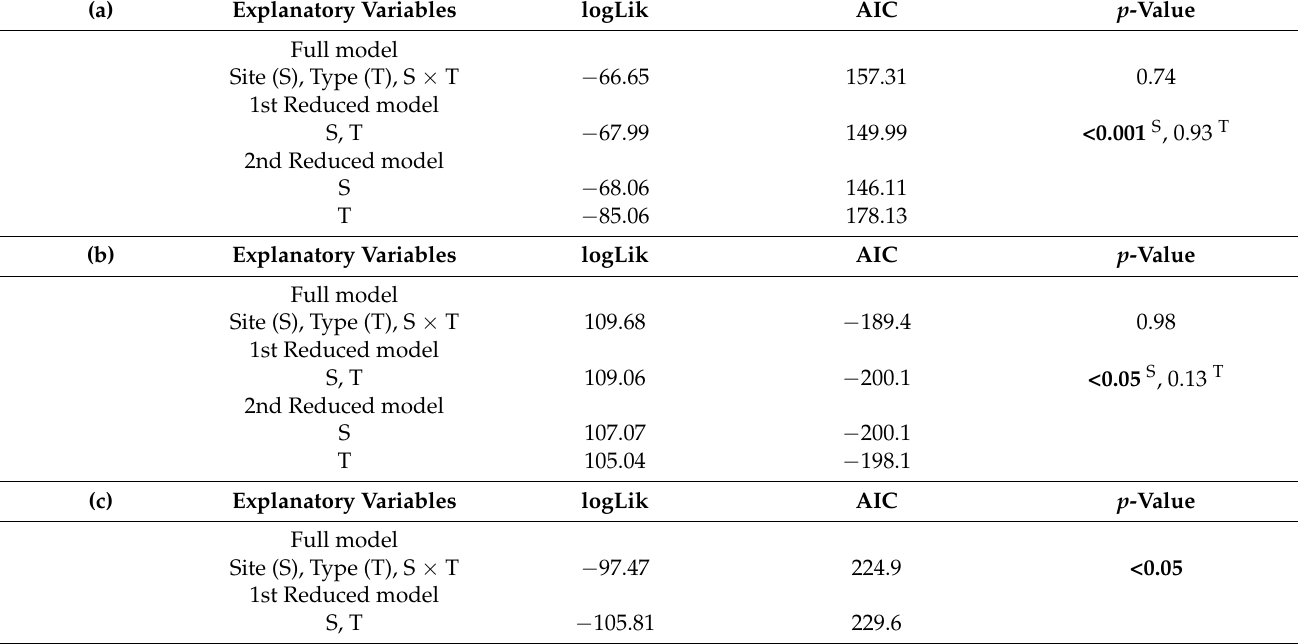
Table 1. Results of GLMMs testing the effects of site (Site: four sampling sites) and habitat-treatment type (Type: benthic zone, control hyporheic zone, and treatment hyporheic zone) and their interactions on log 10 -transformed nitrate concentra- tion ( a ), the effects of site and habitat-treatment type and their interactions on log 10 -transformed two-week mean water temperature ( b ), and the effects of site and habitat-treatment type and their interactions on log 10 -transformed fine sediment amount ( c ). Full models and reduced models were each compared using log-likelihood tests; when full models were insignificant, 1st reduced models were compared to 2nd reduced models sequentially. Superscripts of p -values indicate the variables removed from the model to test with those from reduced models by one level. Bold letters for p -value denote statistical